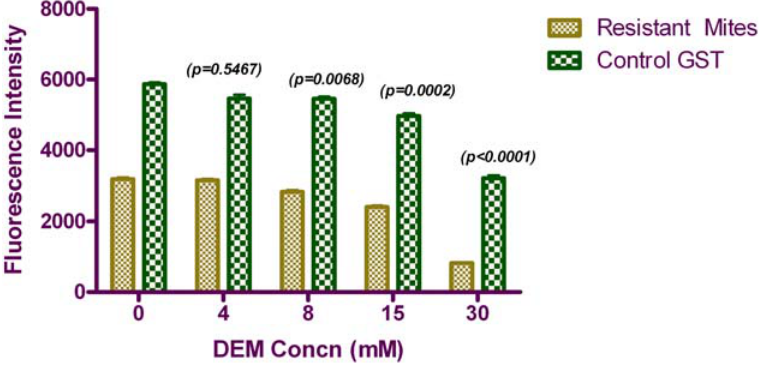
Figure 3. Esterase levels of resistant mites with varying concentrations of DEF. *Error bars represent SEM. **Commercial esterase from rabbit liver was used as assay control.